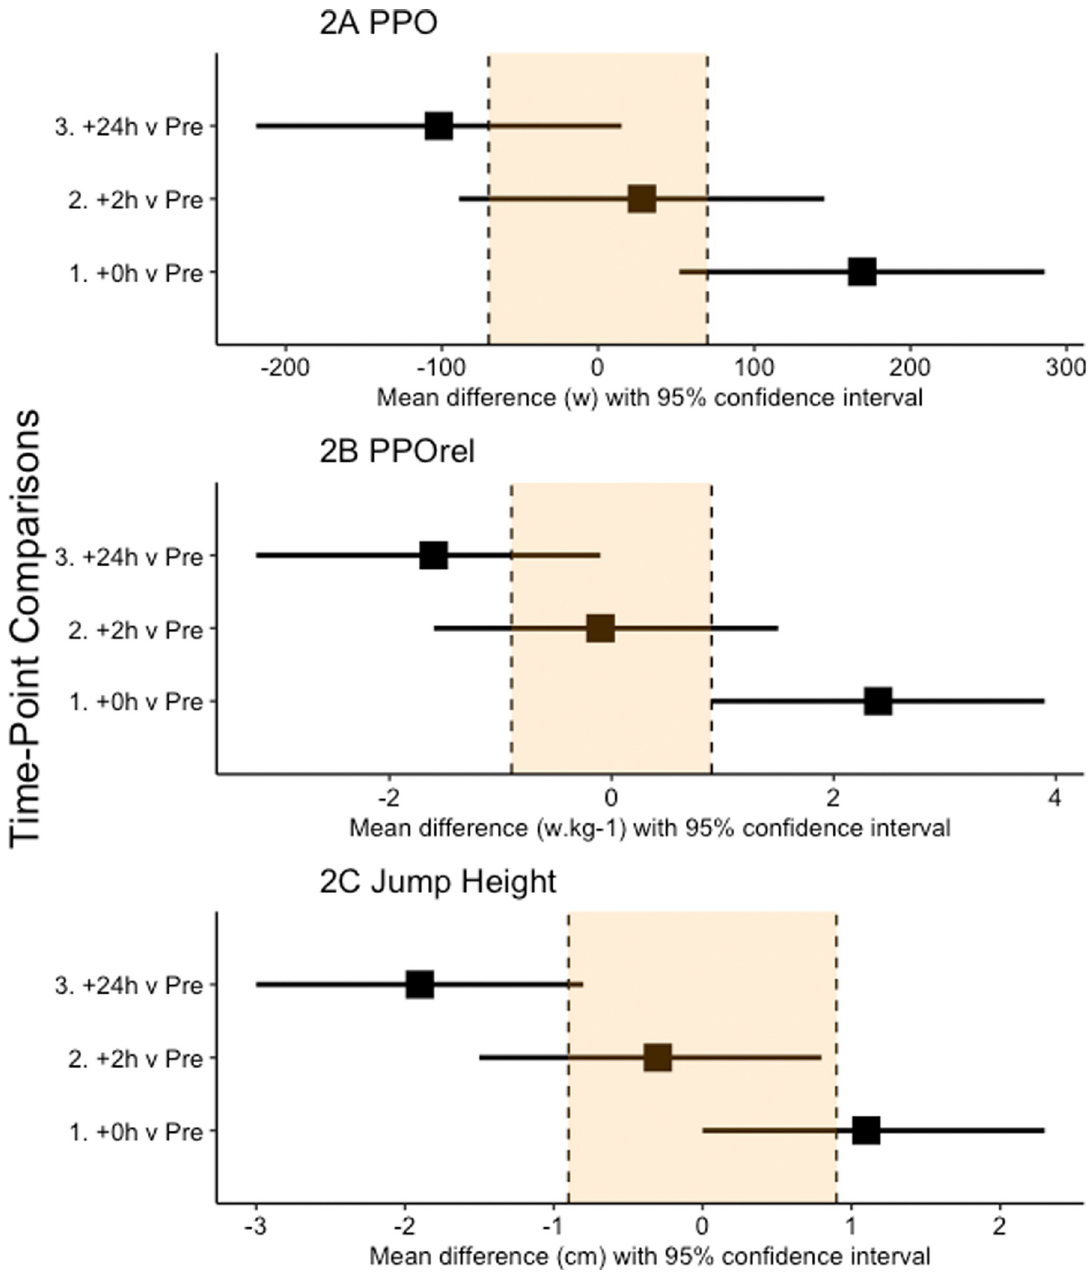
Fig 2. Effect statistics (mean difference and 95% confidence intervals) for the comparison of peak power output (A), peak power output relative to mass (B) and jump height (C) immediately (+0h), two (+2h) and 24 (+24h) hours following the performance of the training session compared to baseline. Zero (0) on the axis represents no difference between that time-point and